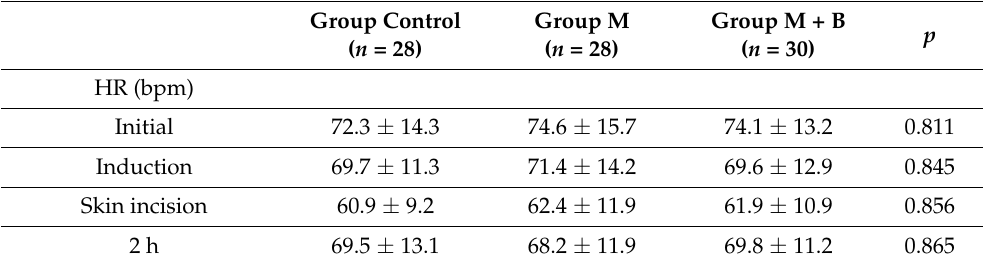
Table 4. Intraoperative